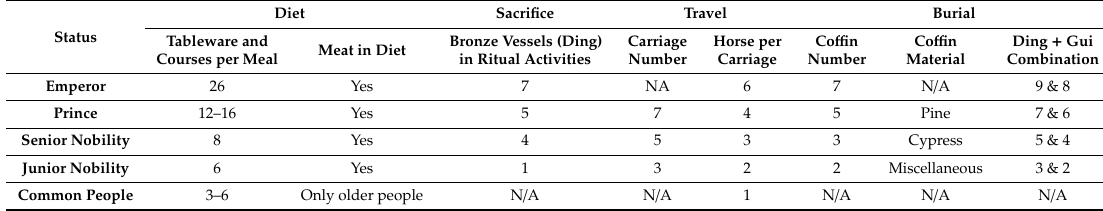
Table 1. Summary of selected differences based on social class in ancient China. This information is